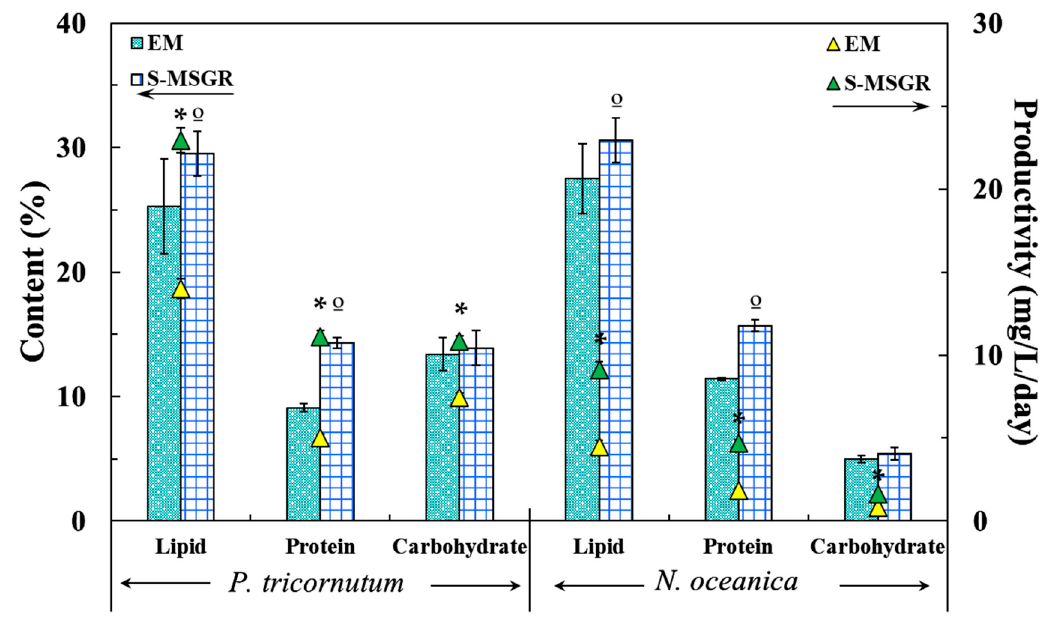
Figure 4. The content and productivity of lipids, proteins and carbohydrates for P. tricornutum and N. oceanica , grown in EM and in S-MSGR. Values are expressed as means ± s.d. ( n = 3). The symbol * indicates the significant difference in the productivity groups ( p < 0.05), The symbol º indicates the significant difference in the content groups ( p < 0.05).